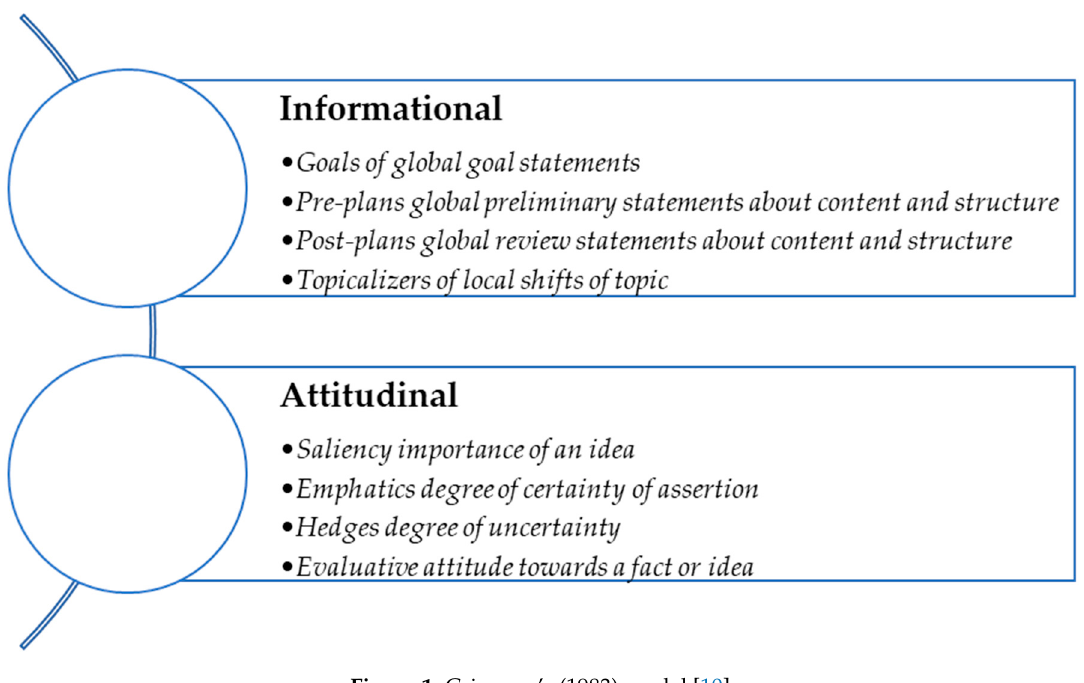
Figure 1. Crismore’s (1983) model [10].